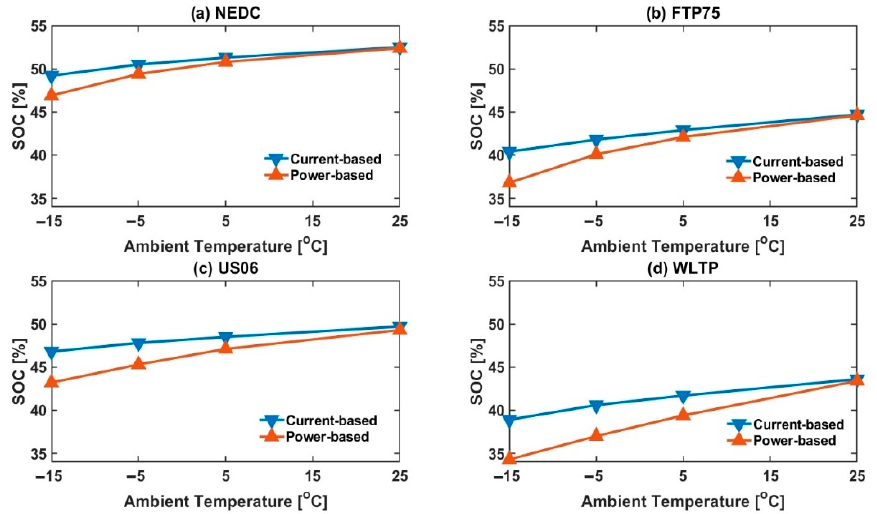
Figure 11. Comparison of end SOCs for current-based (I (t)) and power-based (P (t)) Legislative drive cycles at different ambient temperatures for 65% starting SOC: ( a ) NEDC, ( b ) FTP75, ( c ) US06 and ( d ) WLTP-3.